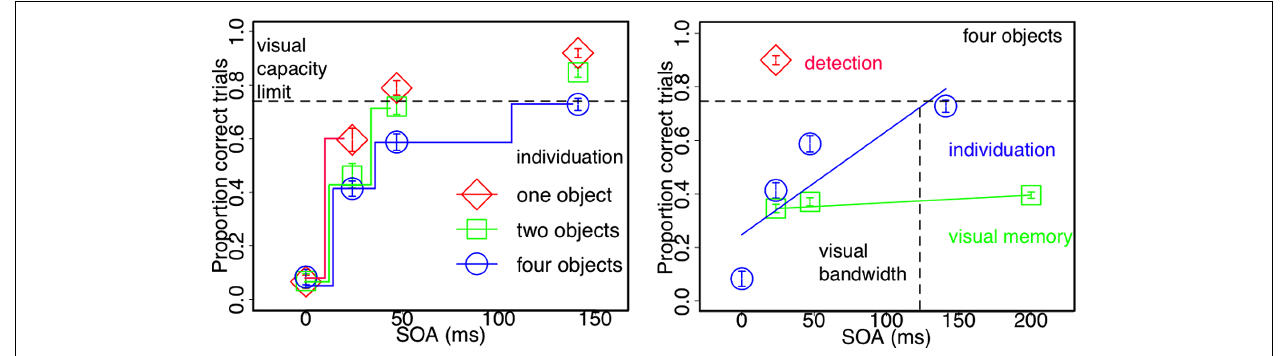
Right panel: detection is faster and visual memory slower than individuation. The onset of four visual stimuli can be reliably detected with as little as 25 ms between mask and target onsets. Individuation of four objects, however, increases in steps for up to 100 ms as a function of SOA.Visual memory for four objects that requires identity integration with individuated object-files remains stable and low across SOAs (Figures adapted with permission from Wutz etal., 2012 andWutz and Melcher,